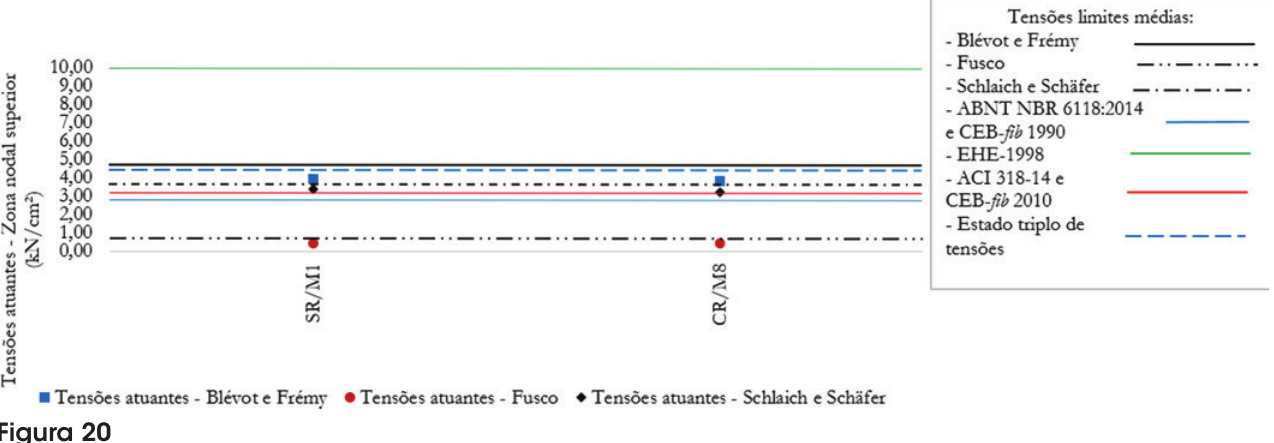
Modelos ensaiados por Barros [10] × σ